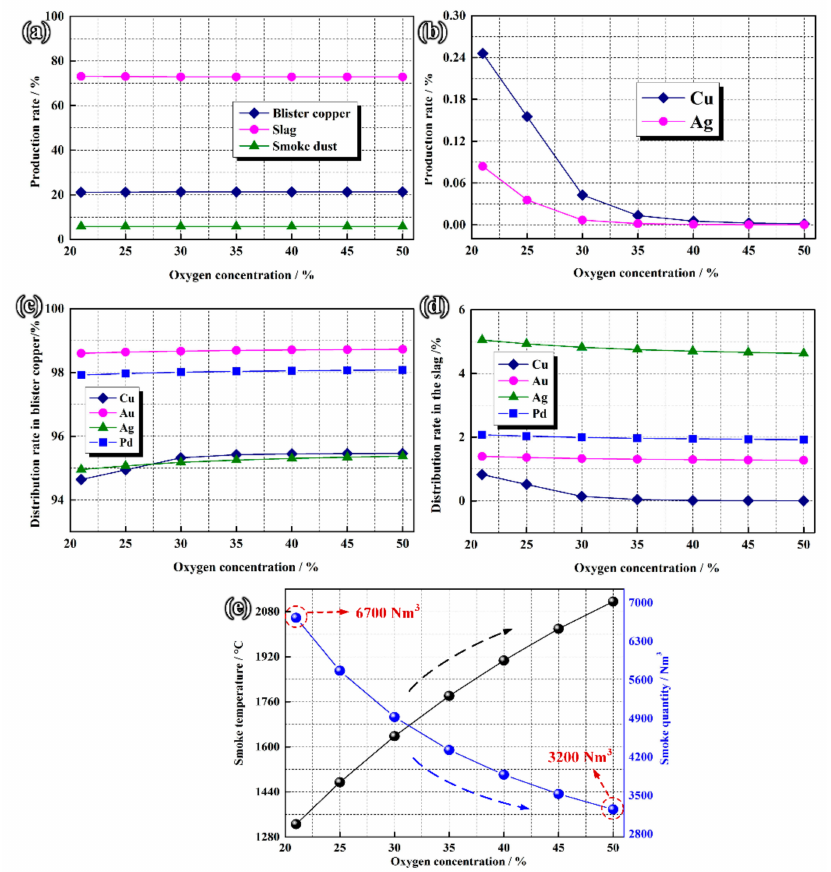
Figure 5. The influence of oxygen concentration on the top-blowing smelting of electronic waste. ( a ) Production rate of blister copper, slag and smoke dust; ( b ) production rate of Cu and Ag; ( c ) dis- tribution rate of various metals in blister copper; ( d ) distribution rate of different metals in the slag; ( e ) smoke